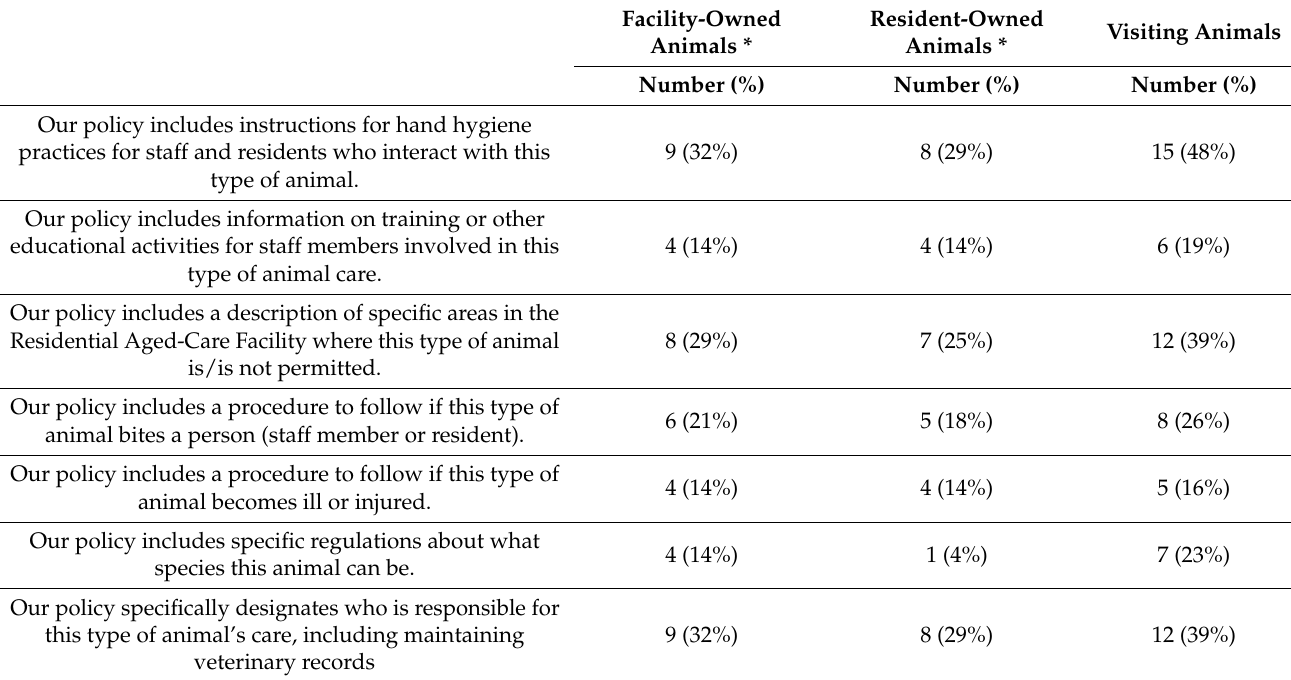
Table 2. Policy provision by animal